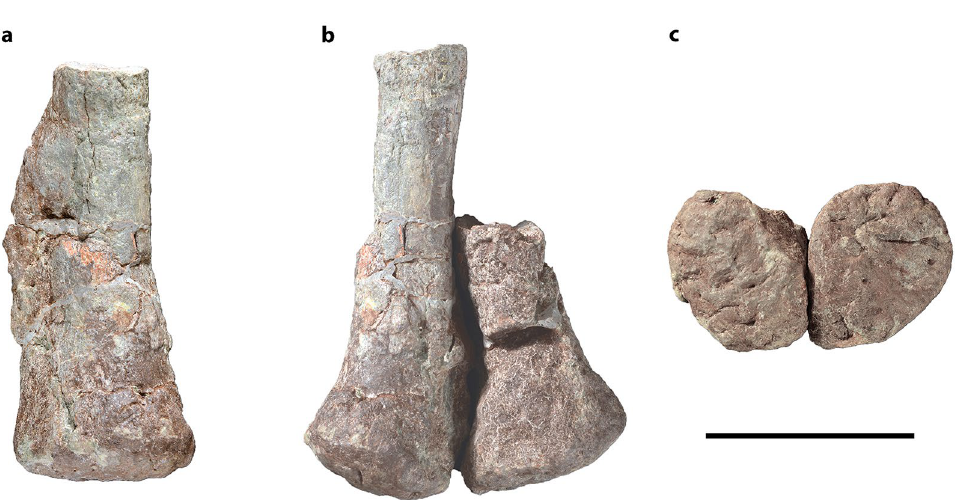
Figure 11. Irisosaurus yimenensis incomplete ischia. ( a ) Left ischium in lateral view; ( b ) Articulated ischia in dorsal view; ( c ) Articulated ischia in distal view. Scale bar = 10